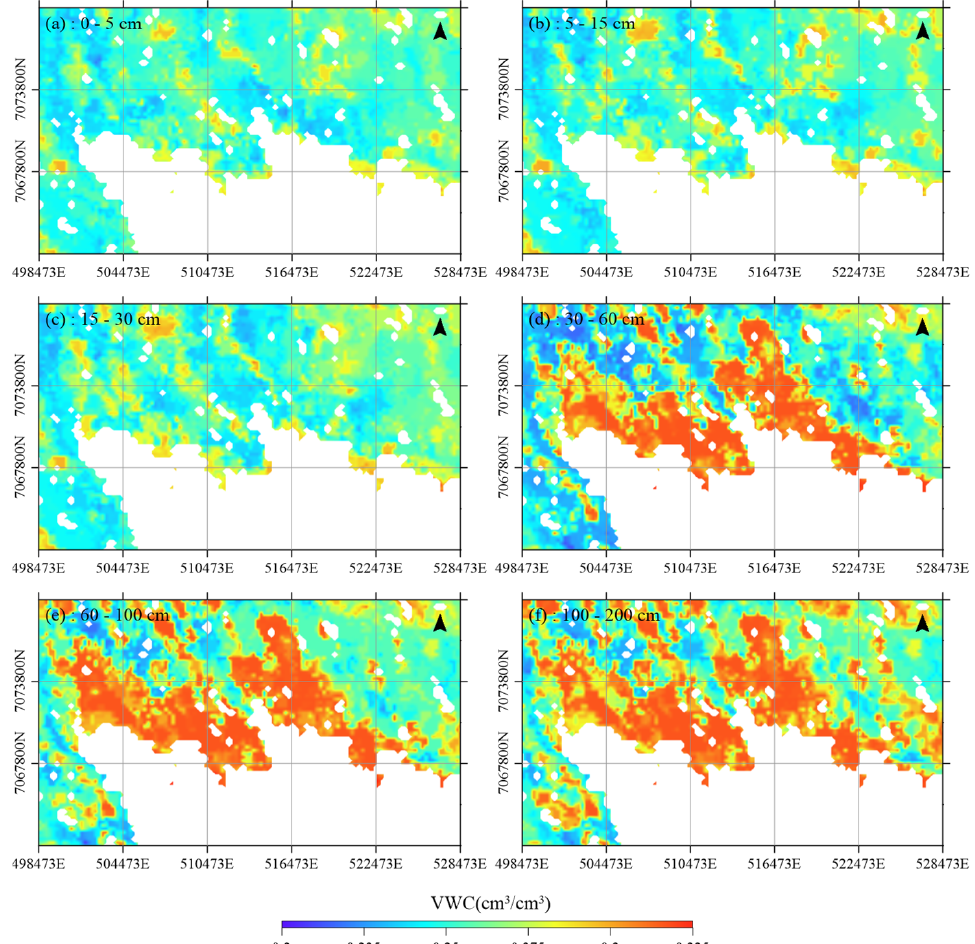
Figure 2. Spatial distribution of soil moisture over Iqaluit at six standard layers under UTM pro ‐ jection.